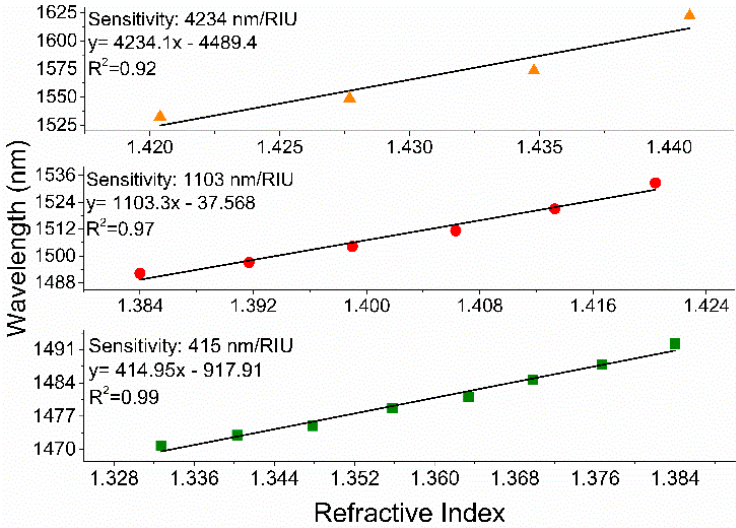
Figure 8. Linearization of the MZI sensor’s wavelength shift necessary to characterize sensitivity in three RI ranges. The characterized sensor has a TWD of 35.5 µm and taper waist length of 19.8 mm. The maximum RI sensitivity of ~ 4234 nm/RIU in the RI range of 1.4204 to 1.4408 was achieved.